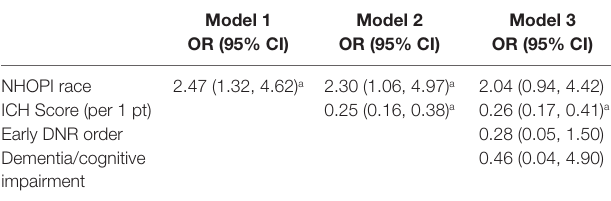
TaBle 3 | Multivariable model to predict favorable 3-month outcome (mRS ≤ 2) after ICH.